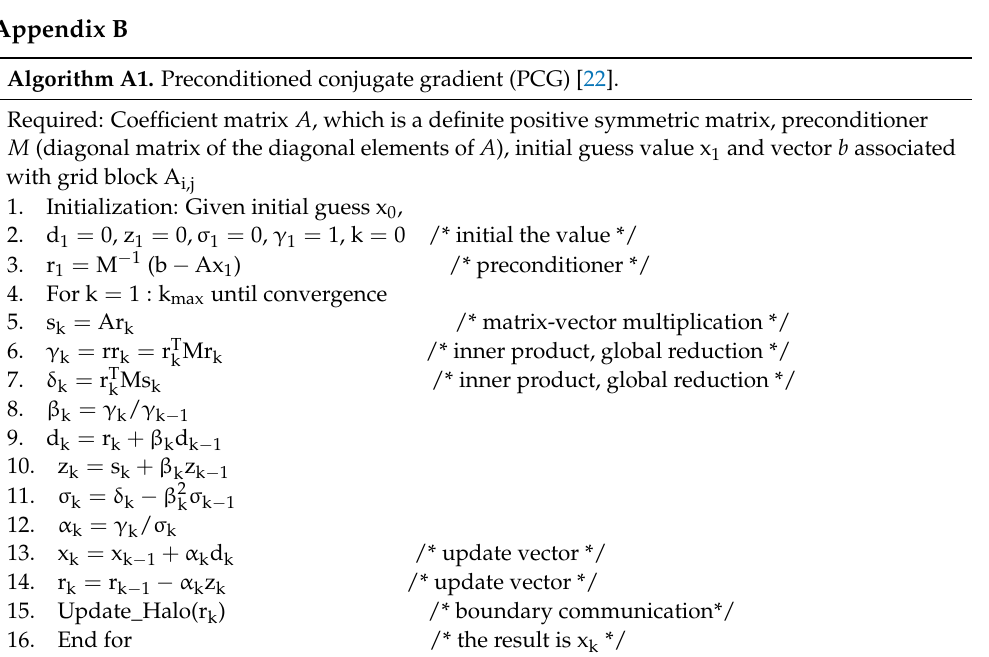
Figure A1. The split time stepping is used in the model. The m represents the time of the barotropic step, and M is the total number of steps among each baroclinic step.